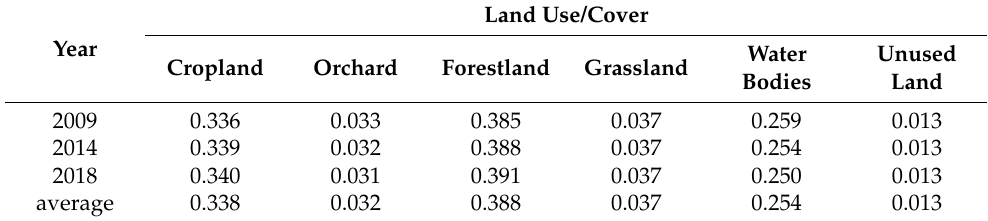
Table 4. Sensitivity of ESV to its value coefficient in Wu’an city.